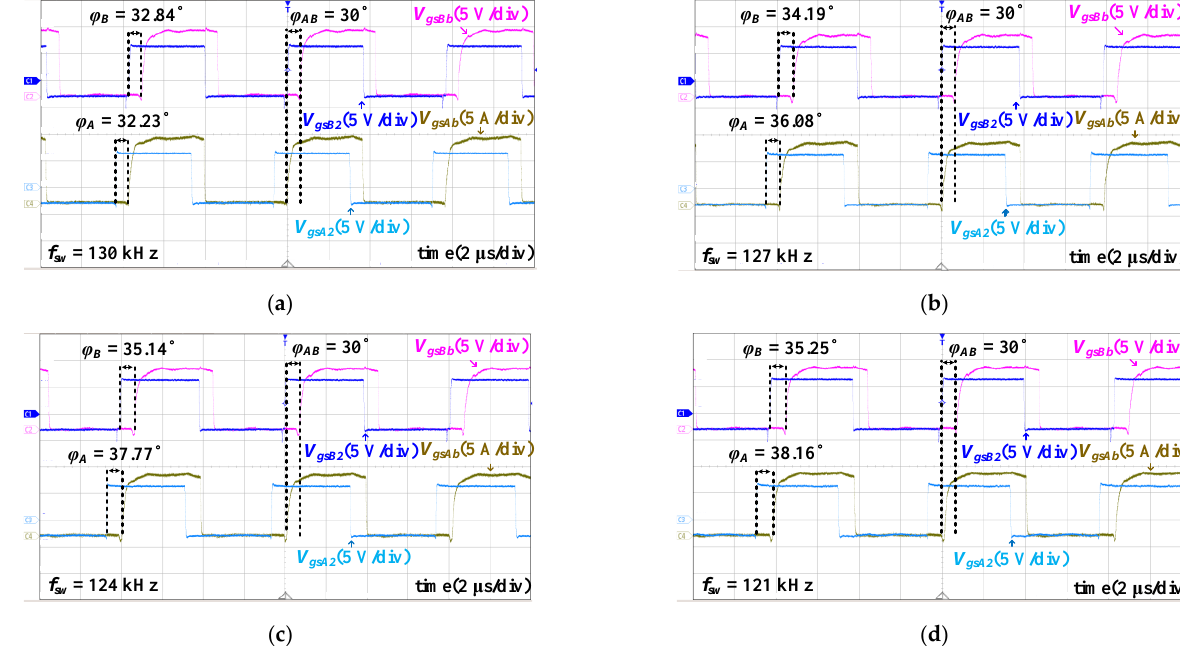
Figure 24. Phase shift waveforms of modules A and B at ( a ) 25%, ( b ) 50%, ( c ) 75% and ( d ) 100% loads. Table 3. The output current error of two modules.